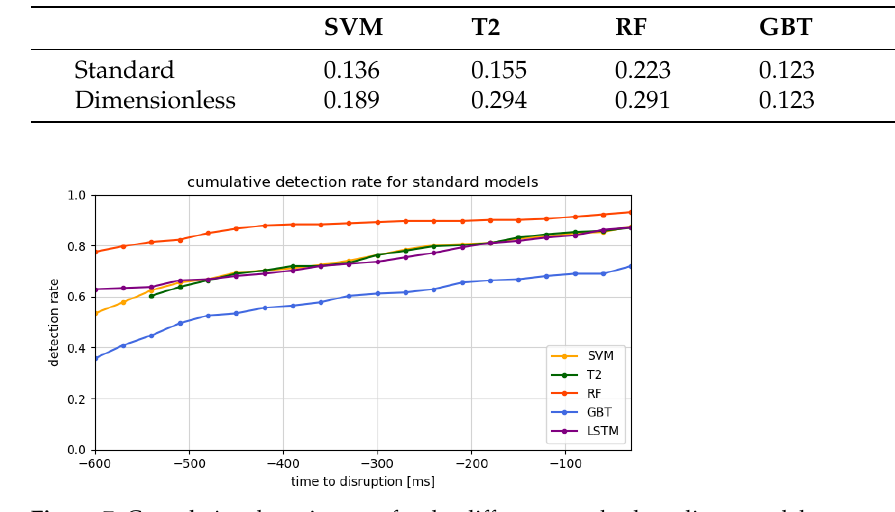
Figure 7. Cumulative detection rate for the different standard predictor models.